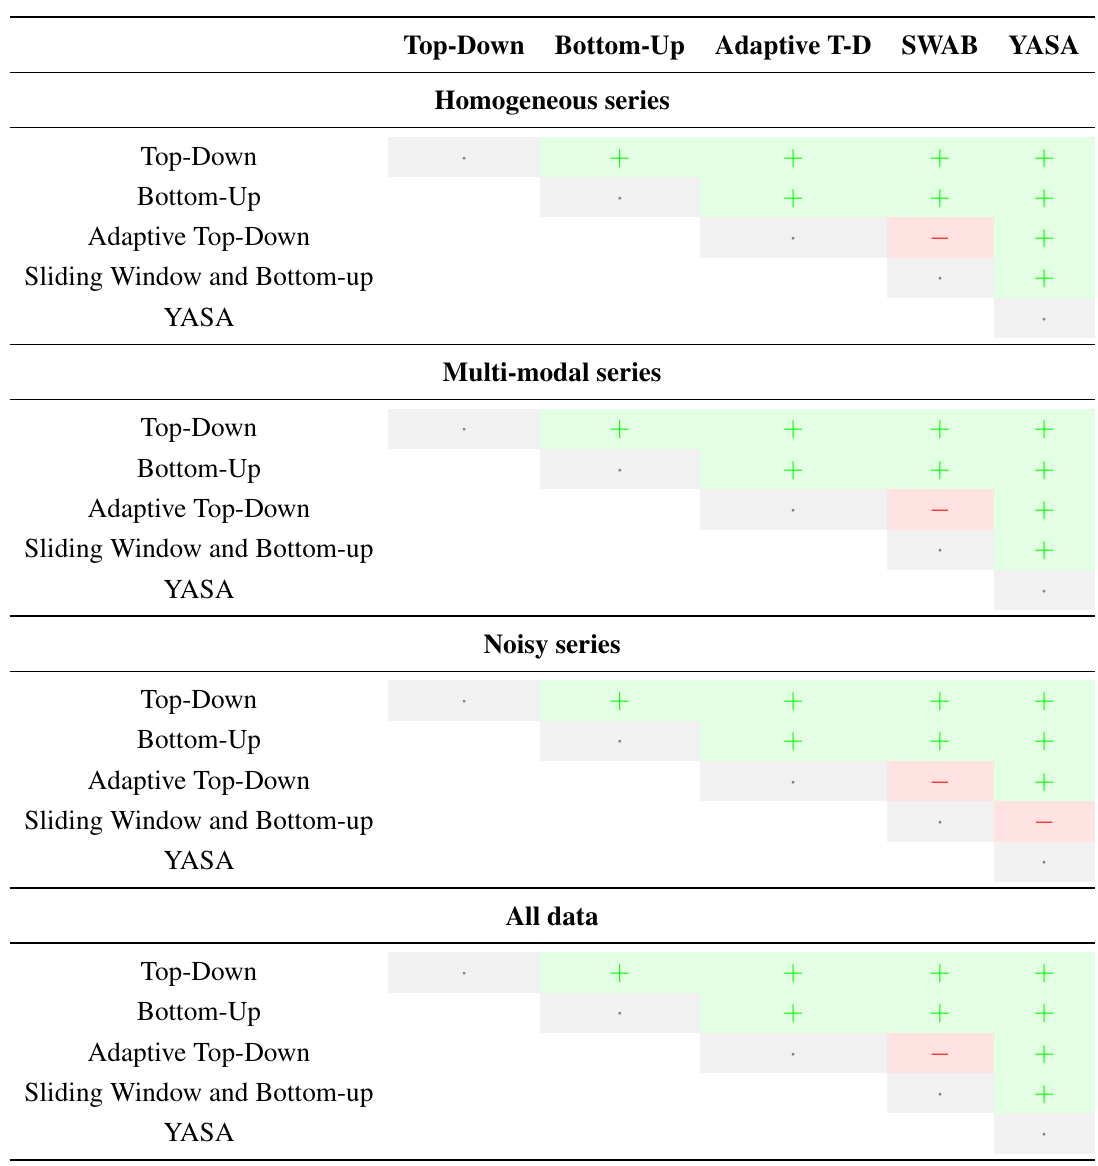
Table 2. Results of the statistical hypothesis tests on the CPU time required to perform the segmentation. Green cells ( + ) mark cases where the results of both algorithms were statistically different. Cells marked in red ( − ) are cases where no statistically-significant difference was